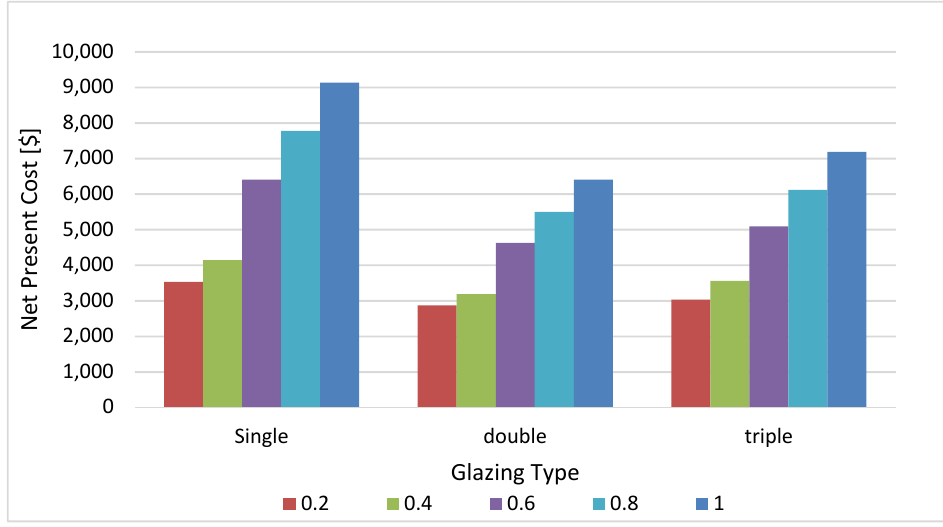
Figure 8. The influence of the window-to-wall ratio and the glazing type on the net present cost of the system in Istanbul (3 cm insulation, NW oriented).